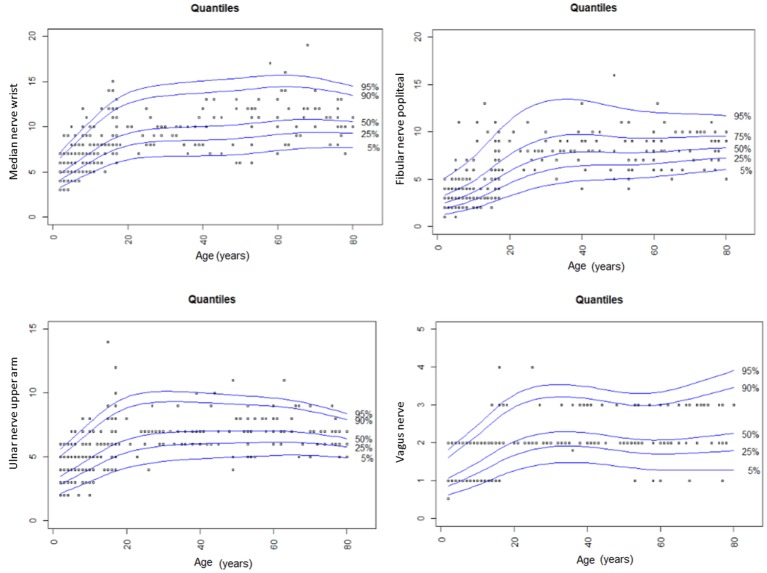
Summary of CSA findings of the median, the fibular, the ulnar and the vagus nerve in our study compared to values in children <8 years and adults of the same study group (9, 10). The nerve growth correlates with age until late adolescents and then reaches its maximum size in the young individual.